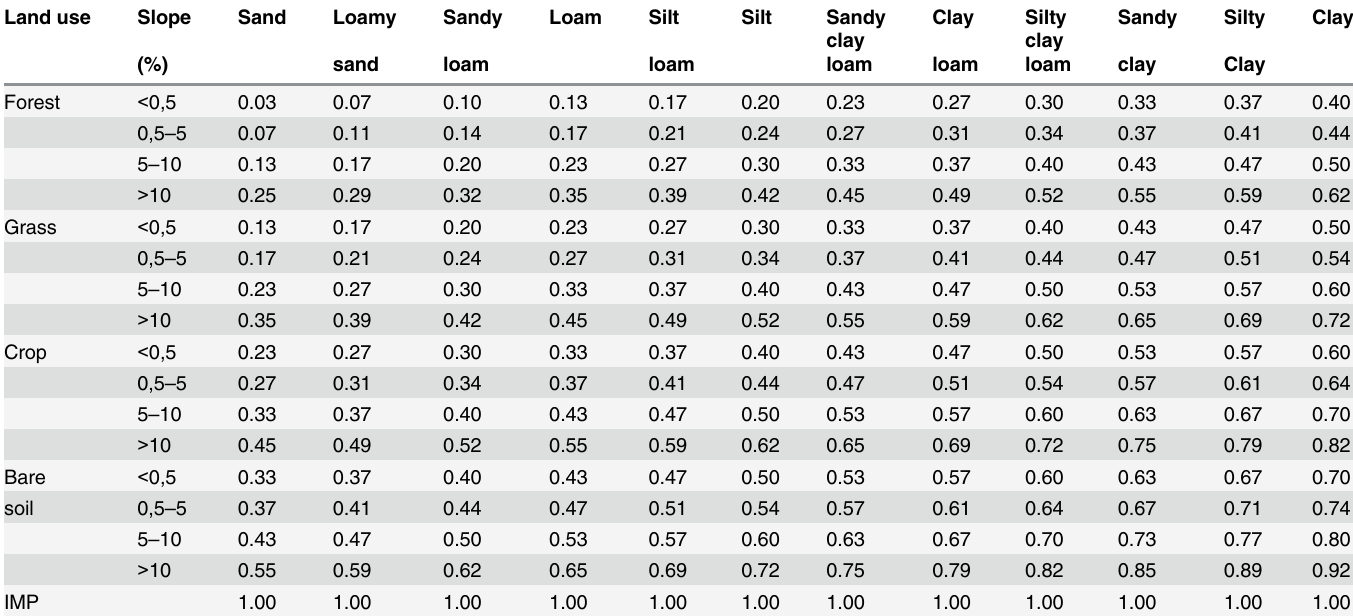
Table 2. Potential runoff coefficient for different land use, soil type and slope.